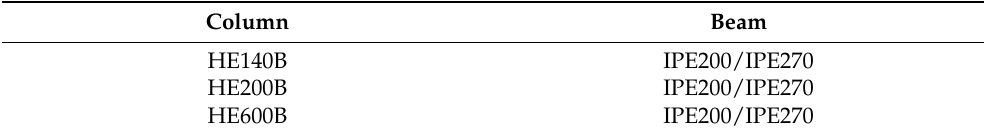
Table 3. Six pairs of beam–column.